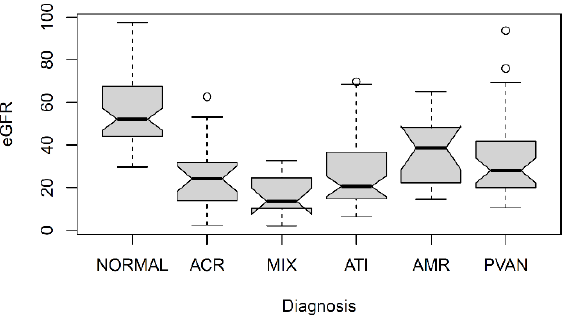
Figure 2. Box-and-whisker plots of eGFR by biopsy diagnosis. Number of samples per box are given in Table 1. Notches indicate the 95% confidence interval of the mean (indicated by the black hori- zontal line).